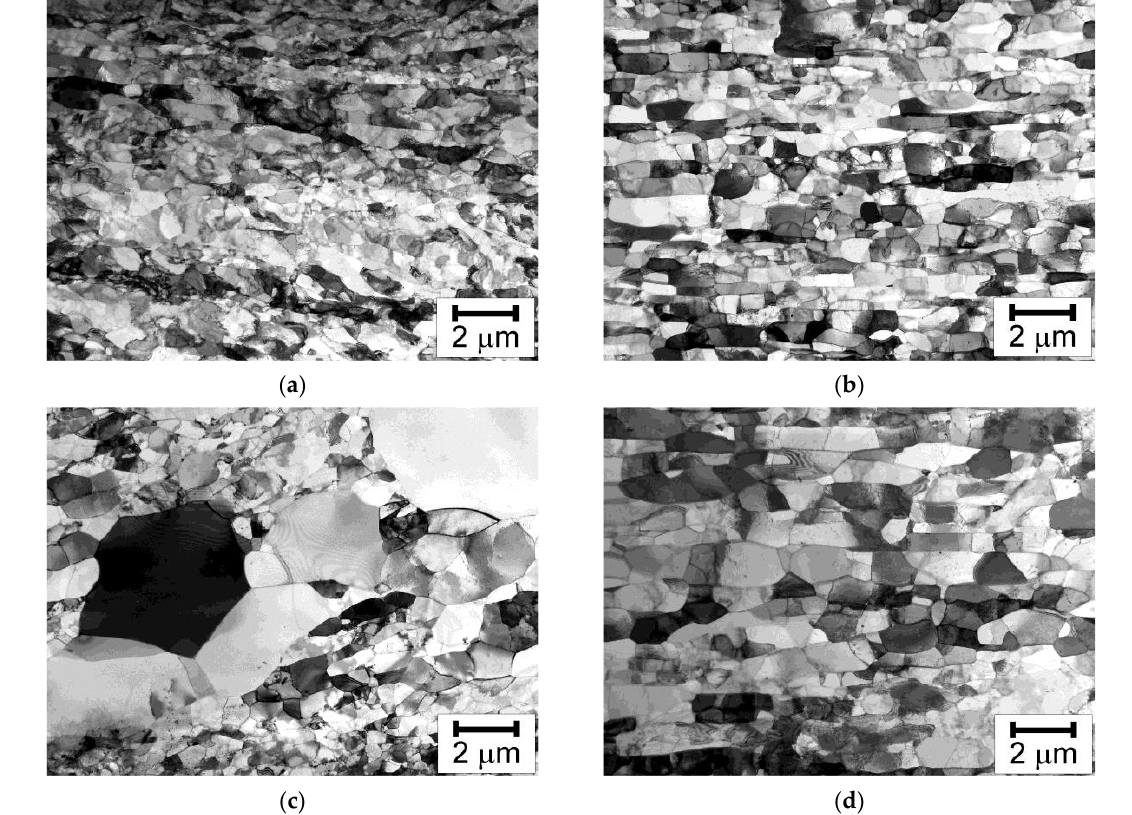
Figure 29. Effect of cold strain on the microstructures in a cold-rolled/swaged Fe-15%Cr steel after 30 min annealing: ( a ) cold strain of 2.0, annealing temperature of 600 ◦ C; ( b ) cold strain of 4.6, annealing temperature of 600 ◦ C; ( c ) cold strain of 2.0, annealing temperature of 650 ◦ C; ( d ) cold strain of 4.6, annealing temperature of 650 ◦ C. Reproduced from [103] with permission from Springer Nature, 2023.